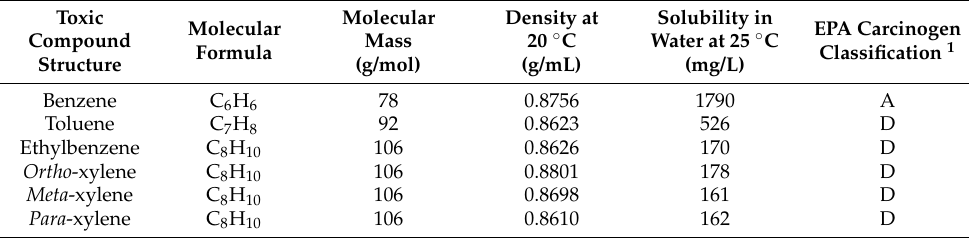
Table 2. The physical and chemical composition of benzene, toluene, ethylbenzene, and xylene (BTEX).